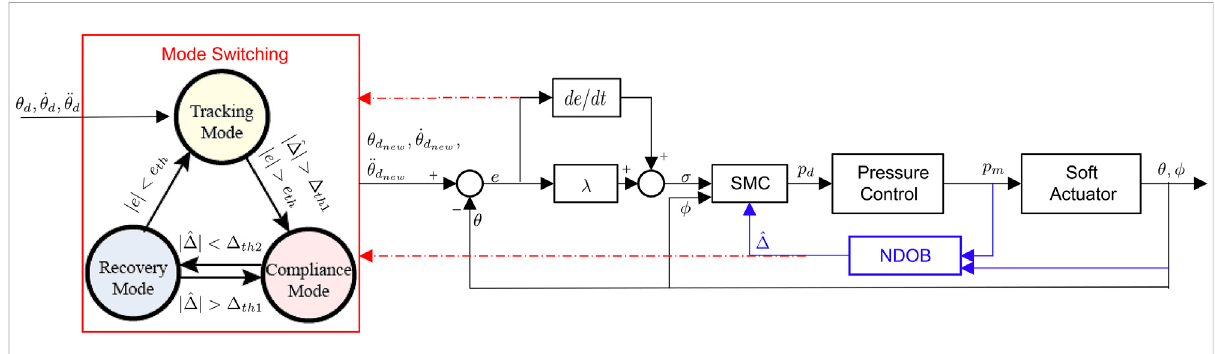
FIGURE 2 Block diagrams of the SMART controller, which consists of a robust baseline controller (SMC), a disturbance estimator (NDOB), and mode switching algorithm based on the estimated disturbance and position